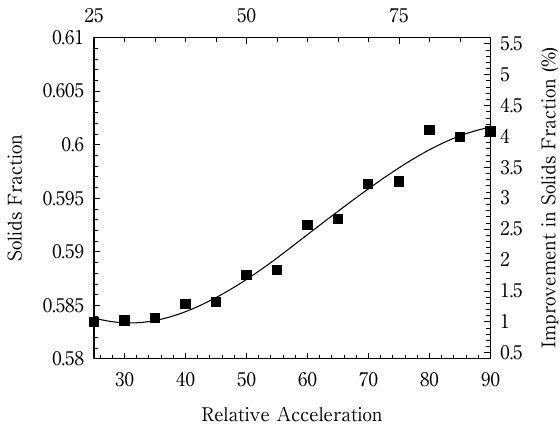
Fig. 6 Solids fraction behavior versus frequency at a/d = 0.02 and N = 600.